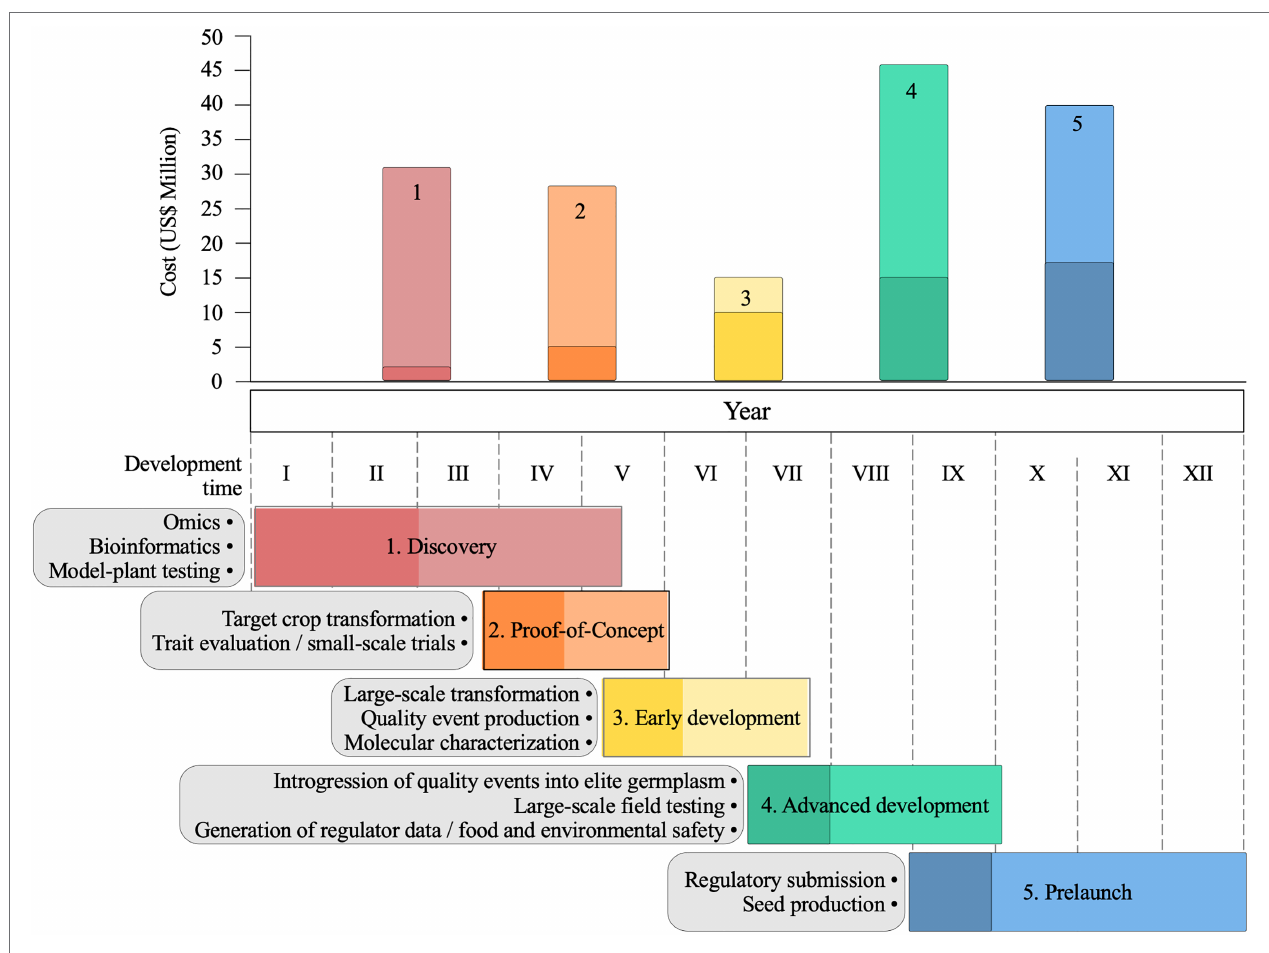
FIGURE 5 | Agricultural biotechnology pipeline for trait development in maize. General overview of main activities and estimates of maximum (light colours) and minimum (dark colours) costs and development time of each pipeline phase: discovery, proof-of-concept, early development, advanced development and prelaunch. Estimates are based on Mcdougall (2011) and Mumm